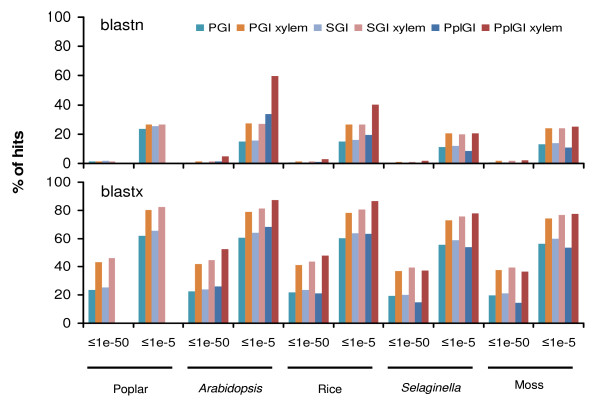
The xylem transcriptome is relatively more conserved in vascular and non-vascular plants. Xylem gene indices and total gene indices of pine, spruce and poplar were blasted (blastn and blastx) against the gene models of Populus, Arabidopsis, rice, Selaginella and moss. Percentage of hits is presented on the Y-axis at E-value cut-offs of 1e-50 and 1e-5. Statistical tests for the different number of hits observed with xylem and total gene indices were performed assuming a binomial distribution. All comparisons showed statistical significances (P < 0.001) (data not show for the simplicity of the figure) except for two comparisons between conifer species and poplar (blastn at 1e-50).